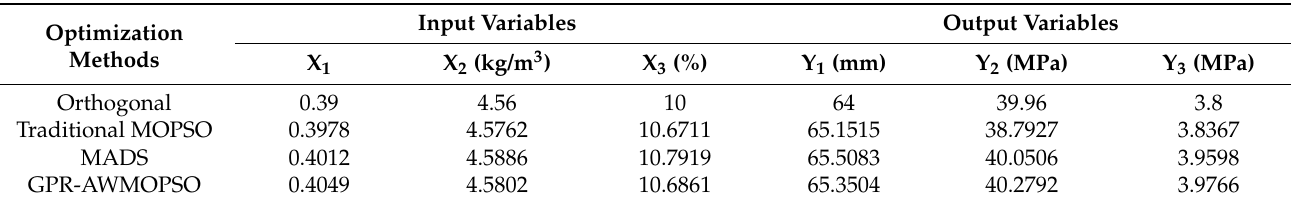
Figure 13. The proportion optimization results for rubber and basalt fibre modified concrete using GPR-AWMOPSO: ( a ) Pareto front showing three objectives (F 1 , F 2 , and F 3 ); ( b ) Pareto front showing three objectives (F 1 , F 2 , and F 4 ) and ( c ) Pareto front showing three objectives (F 2 , F 3 and F 4 ). Table 11. Comparison of optimization results among the traditional orthogonal design [53], traditional MOPSO, MADS and GPR-AWMOPSO